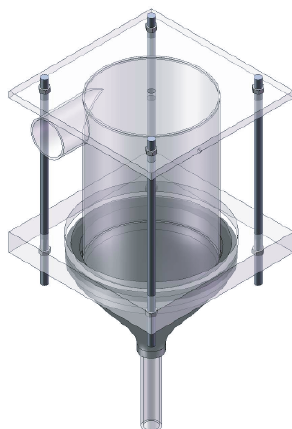
Figure 5. Contoured slug flow expander